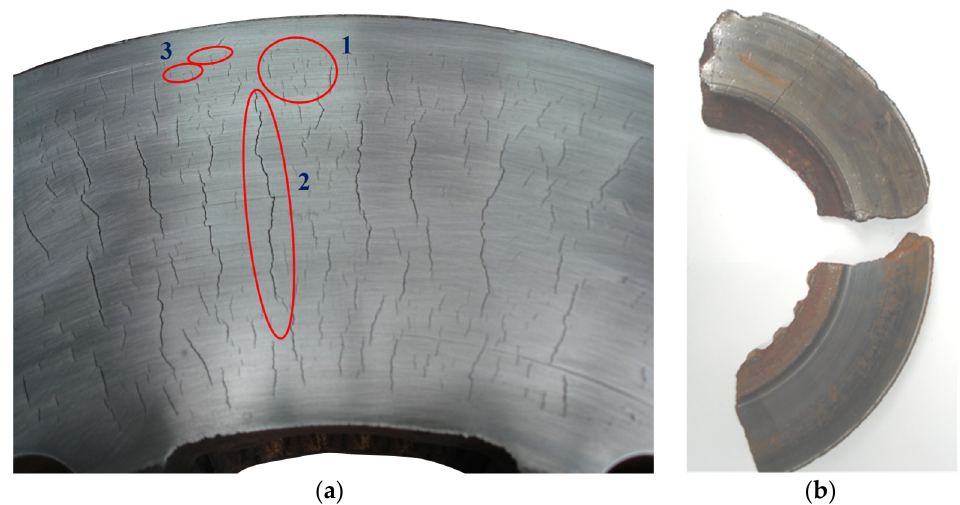
Figure 1. View of a damaged brake disc: ( a ) cracks on the friction surface of the disc; 1—microcracks, 2—radial cracks, 3—circumferential (longitudinal) cracks, ( b ) view of fragments of a cracked brake disc.